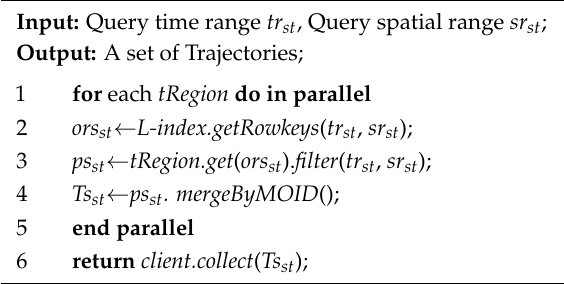
Algorithm 2. Spatiotemporal Range